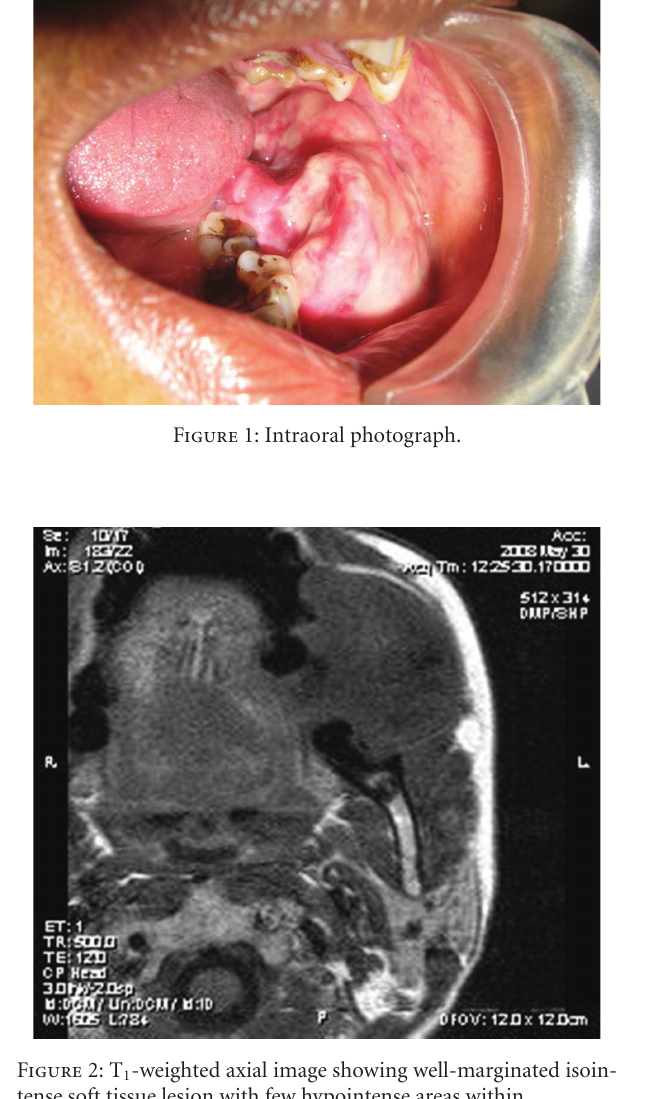
Figure 4: T 2 -weighted axial image showing iso- to hyperintense